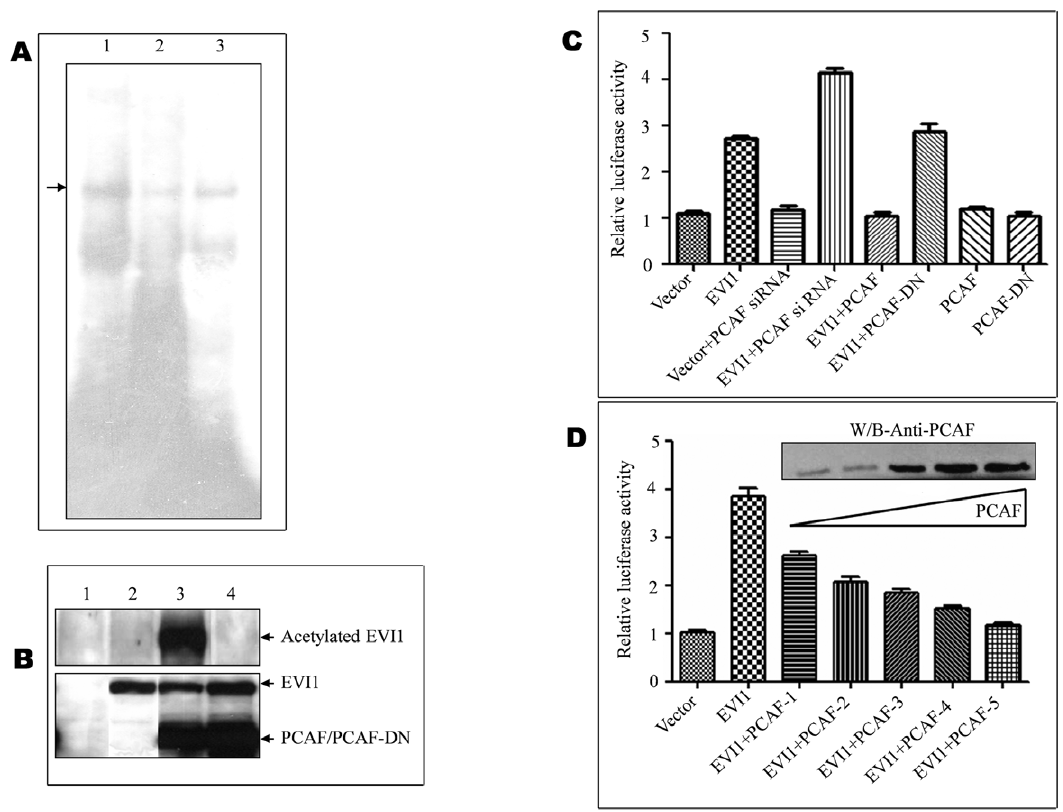
Figure 3. Acetylated EVI1 deregulates Bcl-xL binding and transactivation. A. Nuclear extracts from EVI1-wt or EVI1-wt + PCAF-wt or EVI1- wt + PCAF-DN transfected cells were incubated with a radiolabelled, double-stranded oligo containing the wild type Bcl-xL EVI1 site and analyzed by EMSA. EVI1 binds to Bcl-xL in vitro (as shown earlier) (lane 1). However, acetylated EVI1 (EVI1 + PCAF-wt) failed to bind the Bcl-xL probe (lane 2). The binding was observed again when EVI1 was transfected along with PCAF-DN (lane 3). B. The same nuclear extract was electrophoresed on a SDS- PAGE and transferred to a PVDF membrane which was subsequently probed with the anti acetylated lysine antibody (Cell Signaling Technology, USA). Acetylated band of EVI1 was observed only when EVI1 was transfected along with PCAF (upper panel, lane 3) whereas no acetylated band was observed when EVI1 was transfected alone (upper panel, lane 2) or with PCAF-DN (upper panel, lane 4). The same blot was stripped and reprobed with the anti-flag antibody (Sigma). Expression of EVI1, PCAF and PCAF-DN was observed as shown on the figure (lower panel). Lane 1 showed the only empty vector transfected nuclear extract. C. 293T cells were transfected with constructs as mentioned in the figure along with the promoter construct and renilla luciferase (as an internal control). Twenty four hours later the cells were lysed and luciferase activity was measured using the luminometer. Up regulation of Bcl-xL was blocked when cells were transfected with both EVI1 and PCAF-wt; however the block was released when cells were transfected with EVI1-wt and PCAF-DN. Only PCAF-wt and PCAF-DN showed no effect on the promoter activity. The respective fold change with respect to vector for EVI1-wt, Vector with PCAF siRNA, EVI1 with PCAF siRNA, EVI1-wt with PCAF-wt, EVI1-wt with PCAF-DN, PCAF-wt and PCAF- DN are 2.72, 1.18, 4.14, 1.052, 2.89, 1.20 and 1.046 (p value , 0.0001). D. 293T cells were transfected with vector and EVI1 with increasing concentrations of PCAF (1 m g to 5 m g) with the promoter construct and renilla luciferase. Luciferase assay was done as described above. Up regulation of Bcl-xL was blocked by PCAF in a dose dependent manner (p value ,